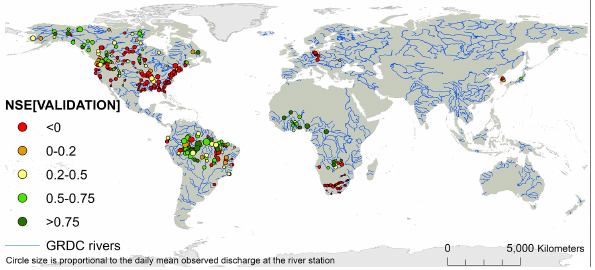
Figure 4. Location of stations and R skill score between in situ- observed discharge and satellite signal (4 days and 4 pixels aver- age). Globally, 169 sites have R > 0 . 3, of which 42 have R > 0 . 5.